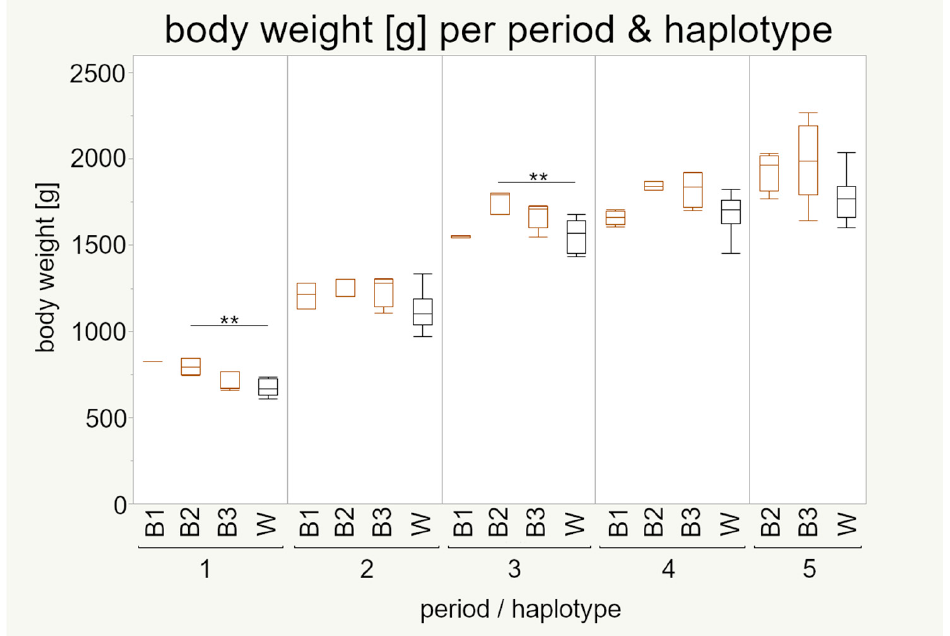
Figure 7. Pairwise Tukey–Kramer HSD or Steel–Dwass tests were used to test for significance within each period. Sample numbers are given in Table 3. Boxes represent 50% of the data points (median with interquartile ranges) whiskers show minimum and maximum. Asterisks indicate significance: ** p < 0.01. Body weight was first studied by Sommerfeld et al. 2020a [27] in the context of strain differences.